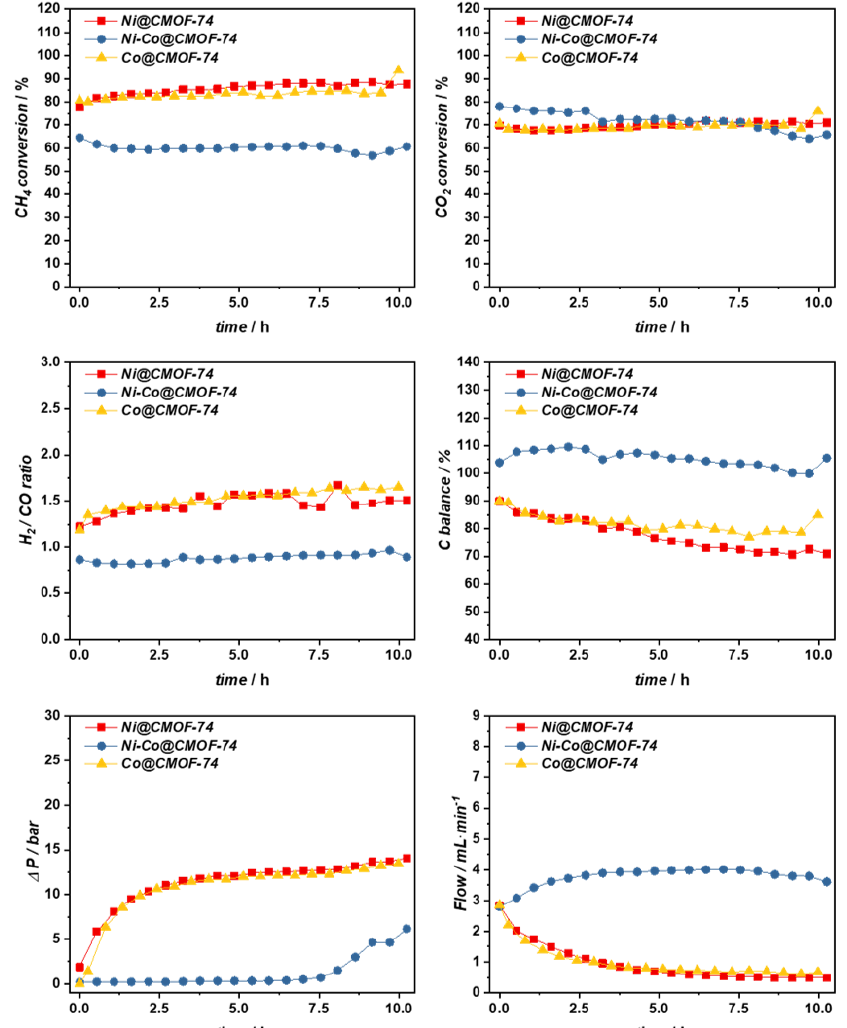
Figure 2. Catalytic results of the different M@CMOF-74 catalysts at 750 °C, 5 bar, 18 L·h −1 ·g −1 .